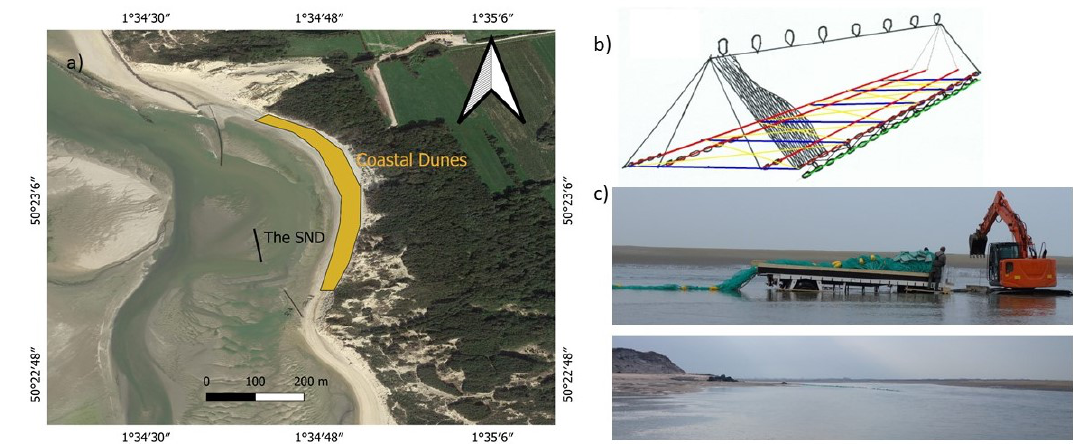
Figure 2. Location of the SND ( a ); schematic of the device: layers of nets assembled in inverted V, buoy to raise the device with the tide ( b ); and the SND in reality ( c